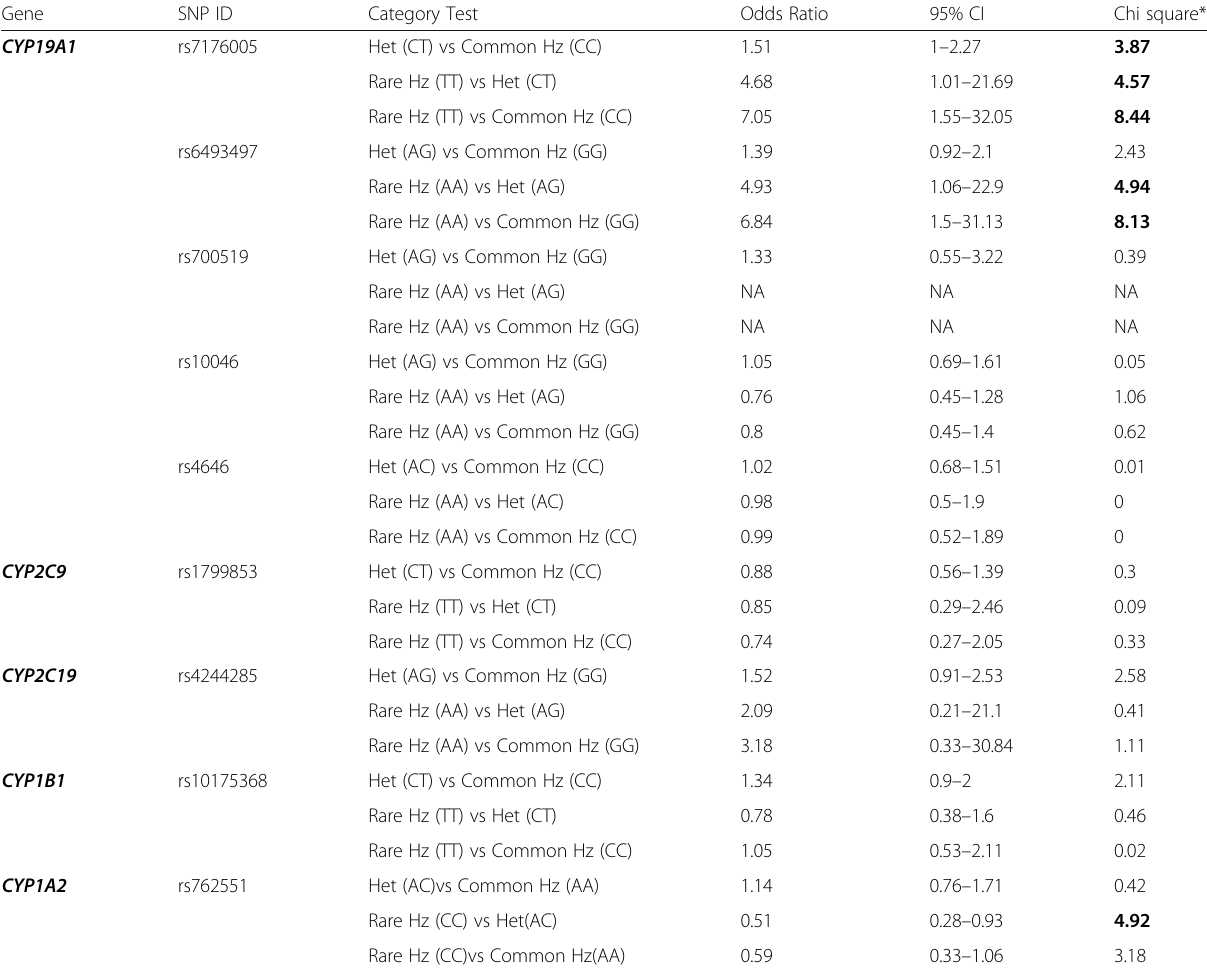
Table 4 Genetic association analysis for the investigated CYP450 candidate gene polymorphisms using different genetic models Gene